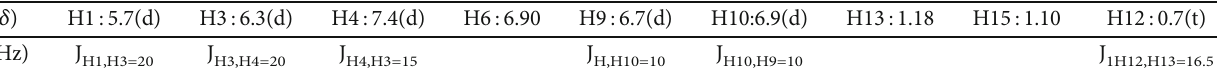
for the Sn-metallic complex. 6